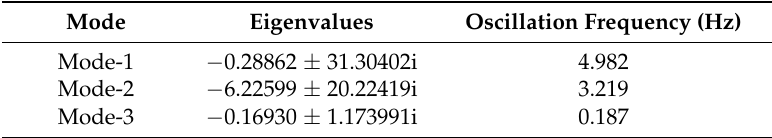
Table 2. Eigenvalue of oscillation modes associated with SSTI.